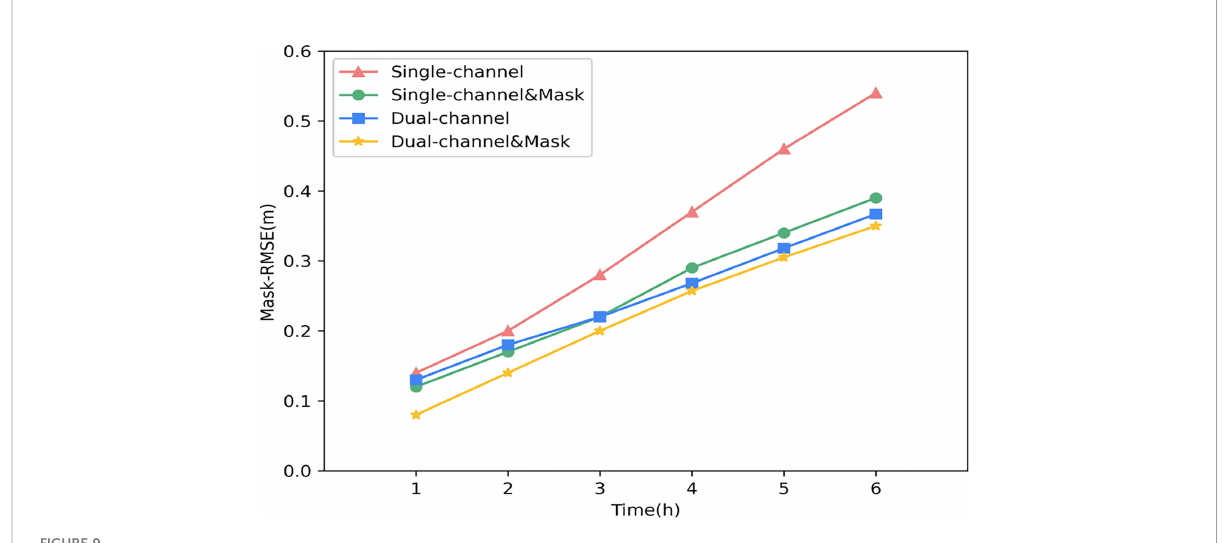
FIGURE 9 Mask-RMSE of the four groups varied with the forecast